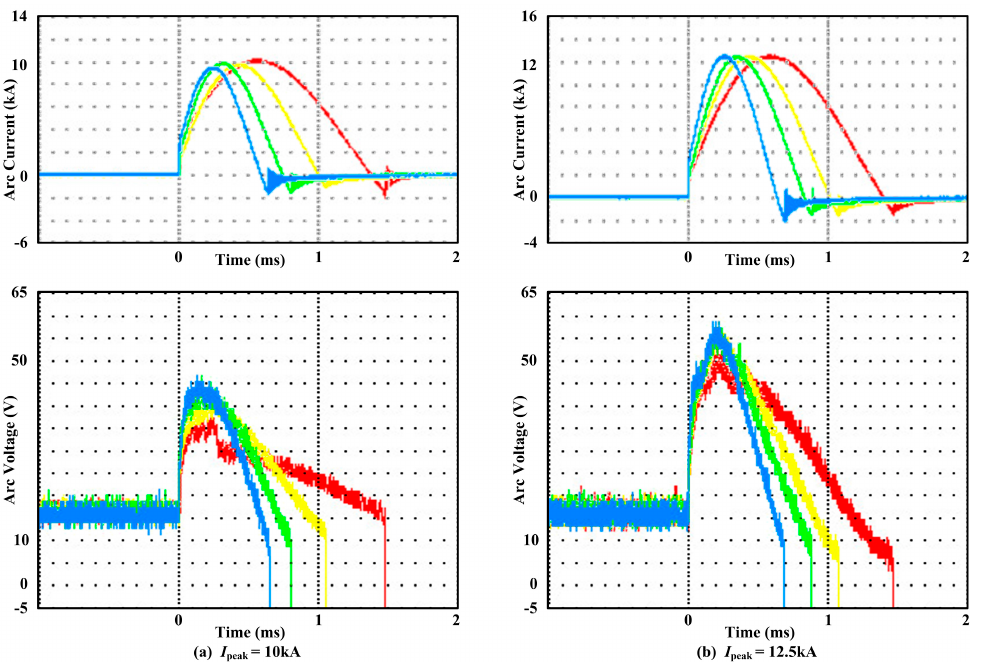
Figure 2. Vacuum arc current and voltage in different frequency ( I peak = 10 kA and 12.5 kA). Table 1. Peak value and time of arc voltage at different frequencies ( I peak = 10 kA and 12.5 kA).